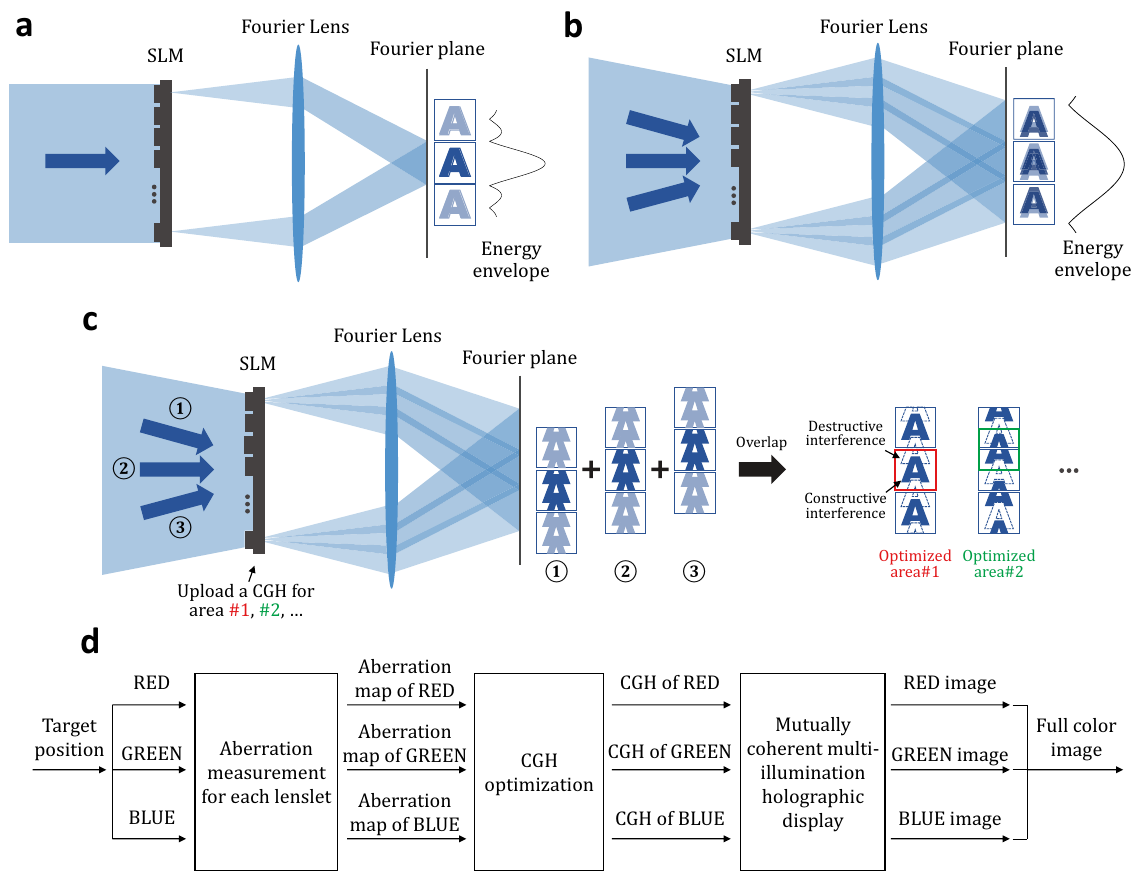
Figure 10. A schematic diagram of multi-illumination holographic displays. ( a ) A conventional single- illumination holographic display generates the narrow energy envelope. ( b ) A multi-illumination adopting to a holographic display can effectively expand the energy envelope, but the reconstructed signals should include critical crosstalk. ( c ) In order to generate crosstalk-free signals, we adopt a mutually coherent multi-illumination to a holographic display. The mutual coherence between each directional wave makes it possible to intensify a target signal and cancel crosstalk signal by constructive and destructive interference, respectively. The optimized area where the target signal is reconstructed can be shifted solely with updates of CGHs. ( d ) A flow chart of the proposed experimental process including optical aberration measurement, CGH optimization, and multi- illumination holographic